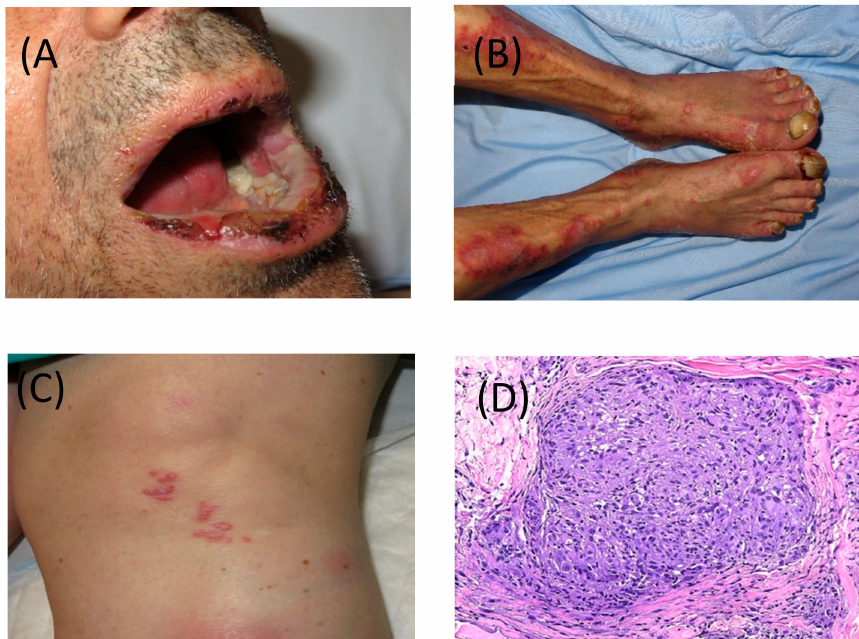
Figure 2. ( A ) Severe and erosive lichen planus-like lesions with involvement of skin and nails and ( B ) of mucosa, after 3 cycles of nivolumab. ( C ) Cutaneous involvement of sarcoid-like granulomatous lesions developed after cessation of pembrolizumab. ( D ) Granulomatous lesion in skin biopsy, magnified 40